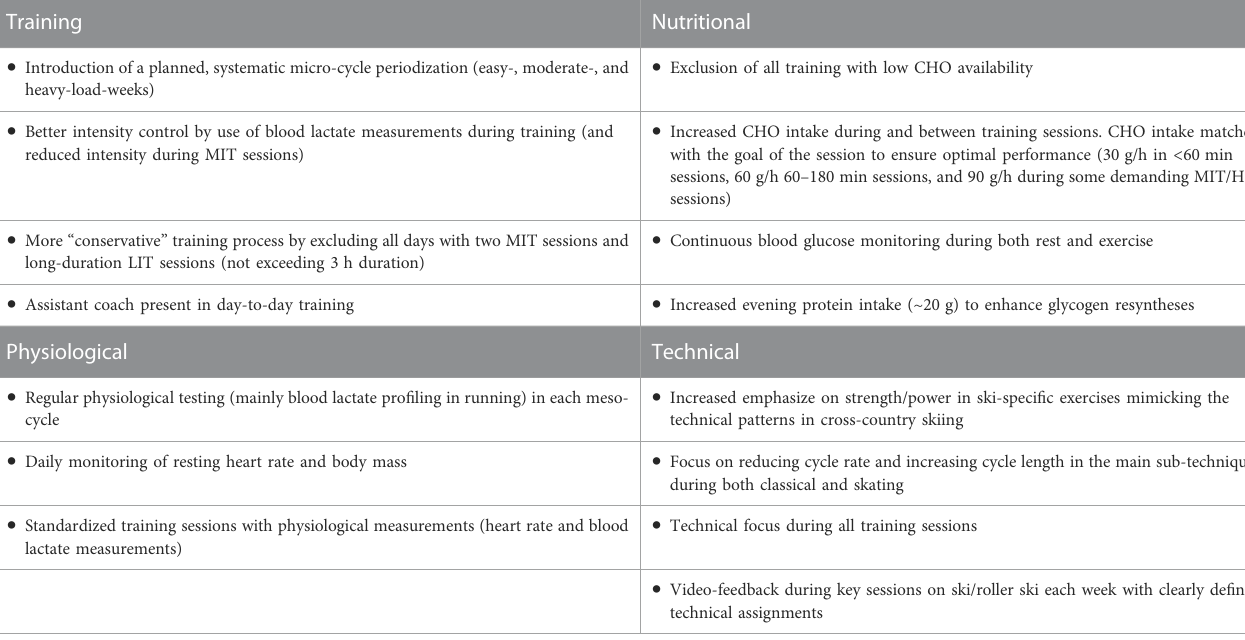
TABLE 3 Different training, nutritional, physiological, and technical interventions in the holistic approach of returning from unexpected underperformance to sustainable world-class level in a male cross-country skier. Training Nutritional